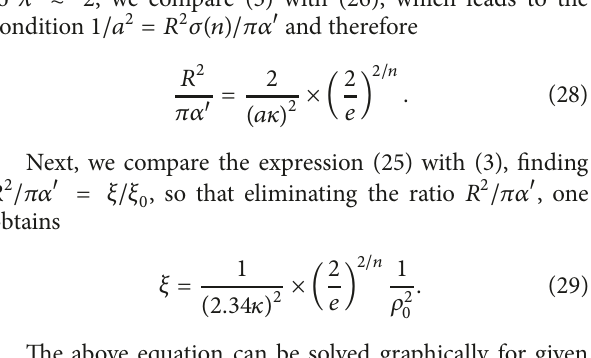
Figure 1: Equation (29) solved graphically: The curves are plots of (29) for some values of 𝜅 with 𝑎 = 2.34 GeV −1 . The horizontal dashed line represents the phenomenological desired value of the parameter 𝜉 , i.e., 𝜉 = 0.52 to fit the Cornell potential.